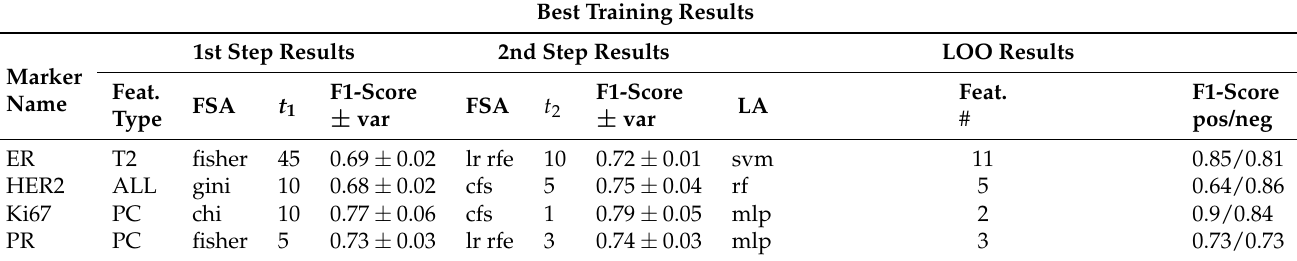
Table 5. Results for the four markers after the proposed two-step pipeline and the model validation and selection. The features and the learning algorithm obtained at the final LOOCV step are used to build the model predictors. Only the best result (in terms of F1-score) is shown here for each marker. Since the classes were unbalanced (except for the PR marker), the F1-score obtained consid- ering both the label values as the positive class is reported. FSA: Feature Selection Algorithm; LA: Learning